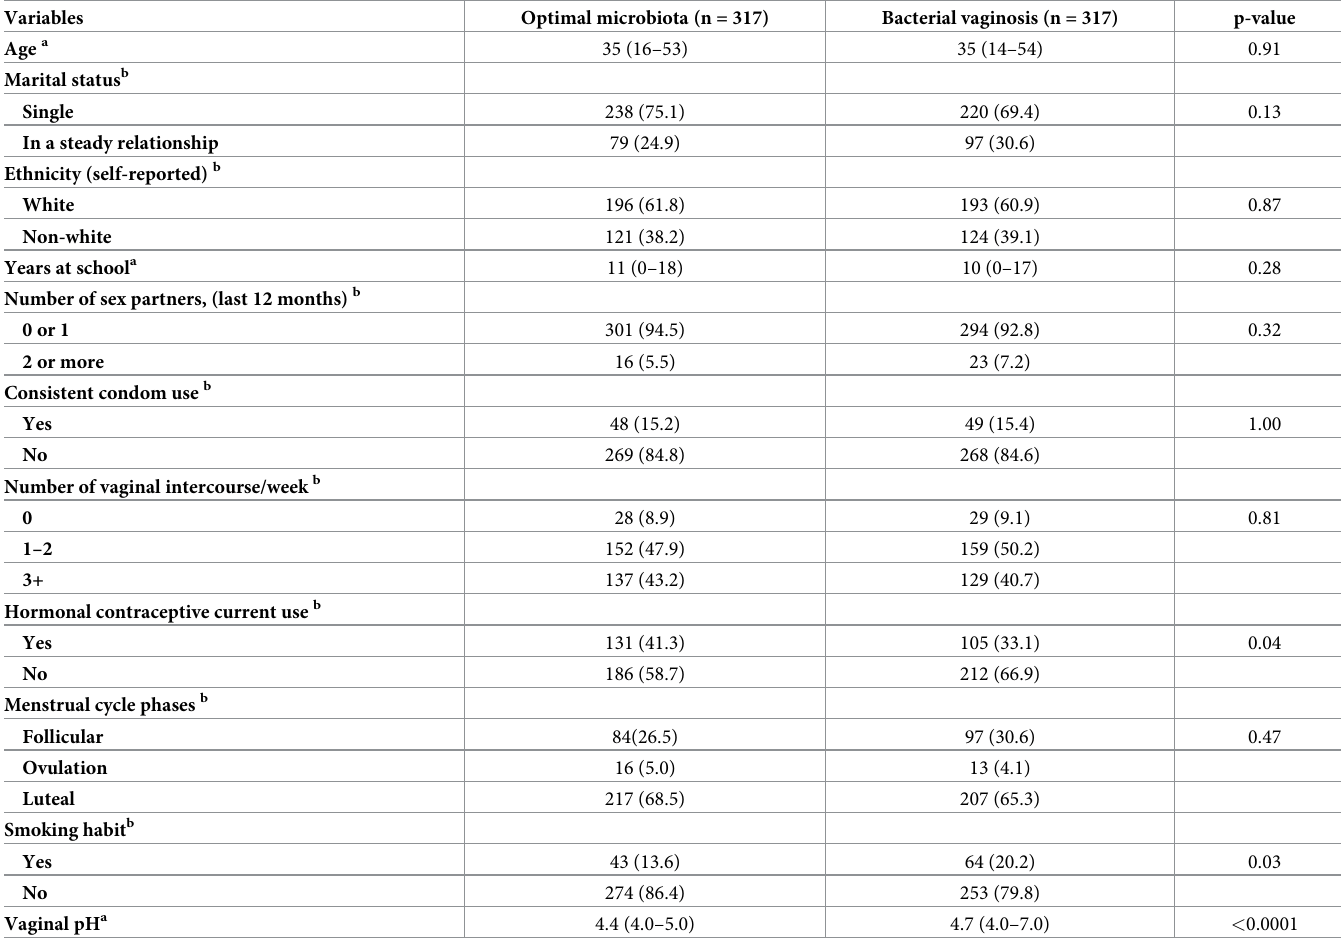
Table 1. Sociodemographic, behavior and clinical characteristics of study population, according to the status of the vaginal